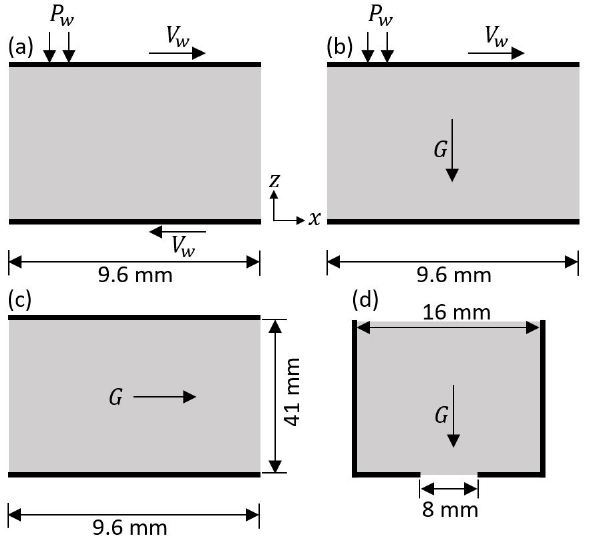
Figure 1. Two dimensional representation of the three dimen- sional geometries being simulated, showing the x and z axes. The y axis is not shown. (a) is a shear cell, (b) is a shear cell with gravity, (c) is a vertical chute and (d) is a pseudo-2D Hop- per. These are not to scale. The width of the first three geometries along the y axis was 9.6 mm, while the hopper was 8 mm. The height of the shear cell and shear cell with gravity was approxi- mately 40 mm, though was varied to maintain a roughly constant wall pressure ( P w ).